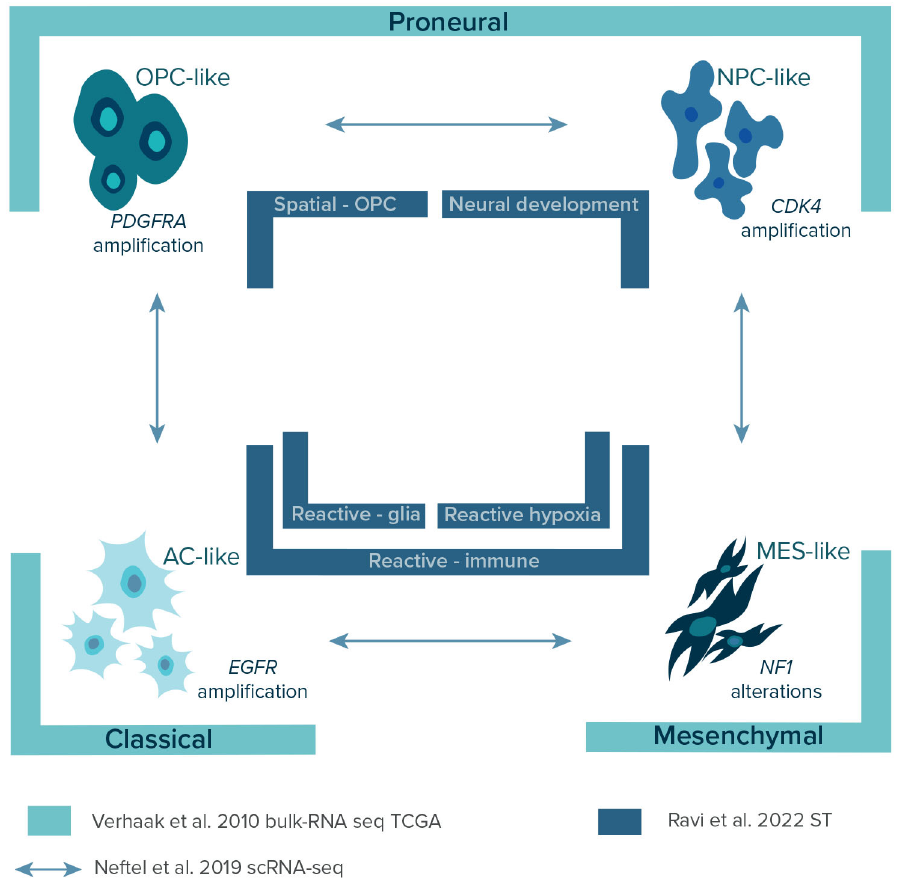
Figure3.Chronologicalpresentationofcharacterizedlayersof heterogeneitywiththeidentifiedcorrespond- ing distinct GBM subtypes. Legend: AC-like – astrocyte-like; CDK4 – cyclin-dependent kinase 4; EGFR – epidermal growth factor receptor gene; MES-like – mesenchymal-like; NF-1 – neurofibromatosis type 1 gene; NPC-like – neural progenitor-like; OPC-like – oligodendrocyte-progenitor-like; PDFGRA – platelet-derived growth factor receptor A gene; scRNA-seq – single-cell RNA sequencing; ST – spatial transcriptomics; TCGA – The Cancer Genome